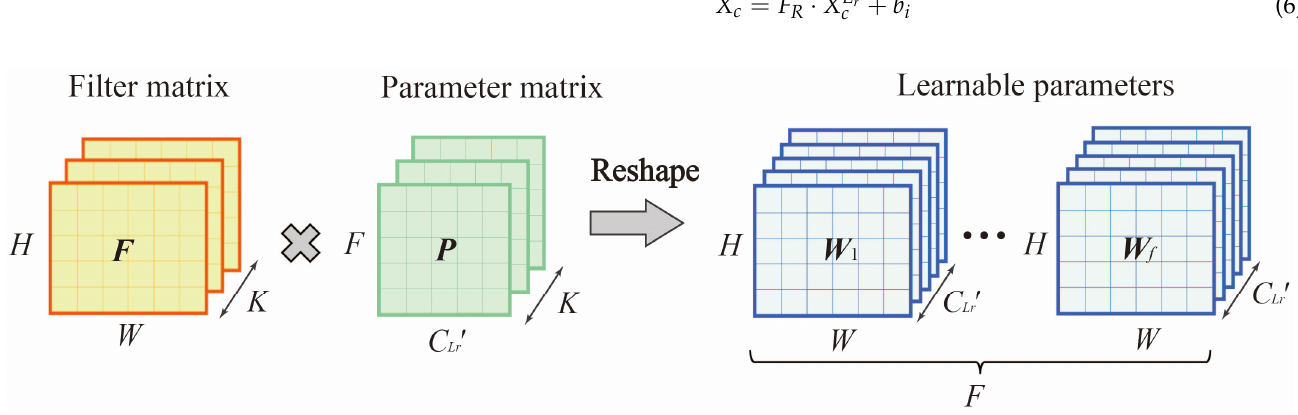
Figure 6. Matrix decomposition of learnable parameters in MFR .